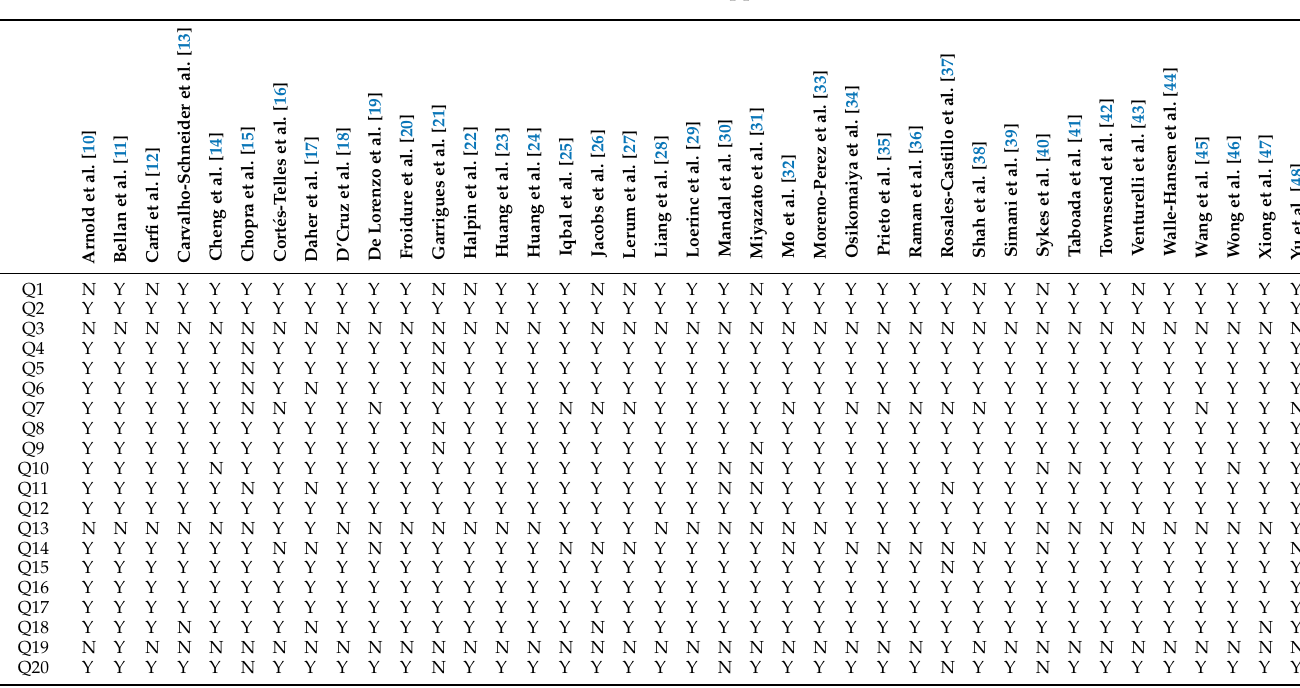
Table 3. AXIS Critical